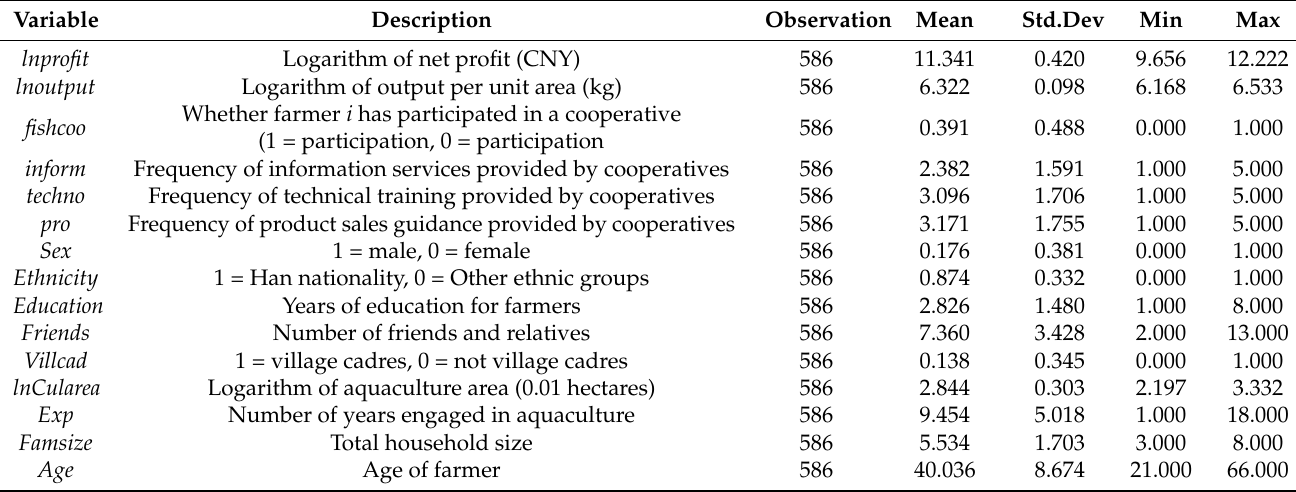
Table 1. Descriptive statistics of all